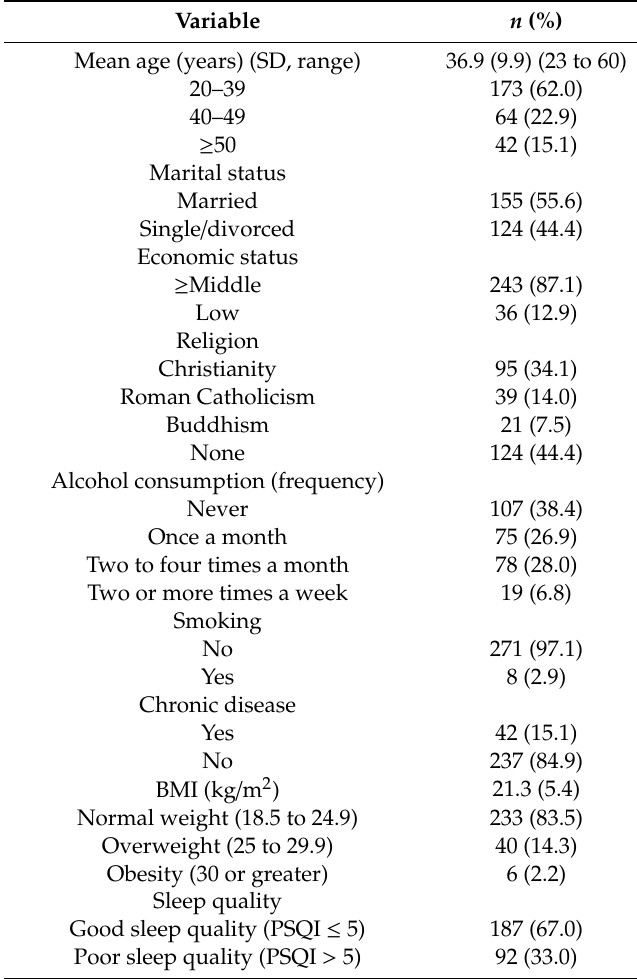
Table 1. Statistics describing the Study Population ( n =